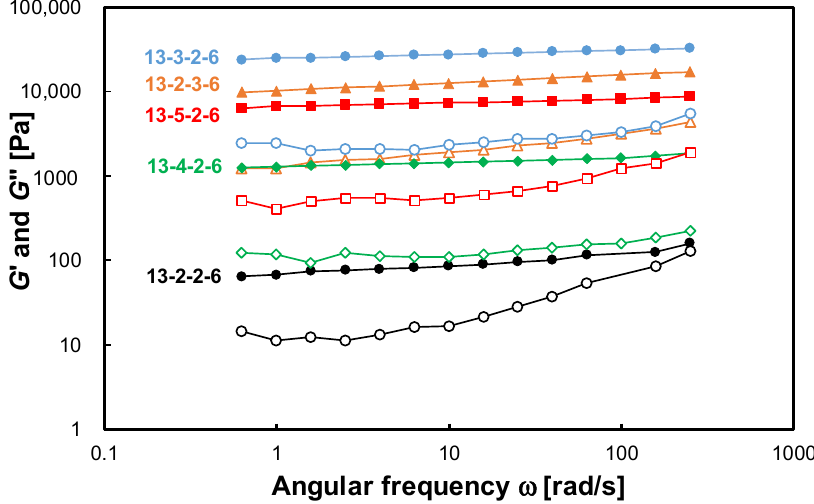
Figure 10. Angular frequency dependence of G ′ (solid symbols) and G ″ (open symbols) of 13- l - m -6 ( l = 2–5; m = 2 and 3) aqueous solutions at 25 °C.